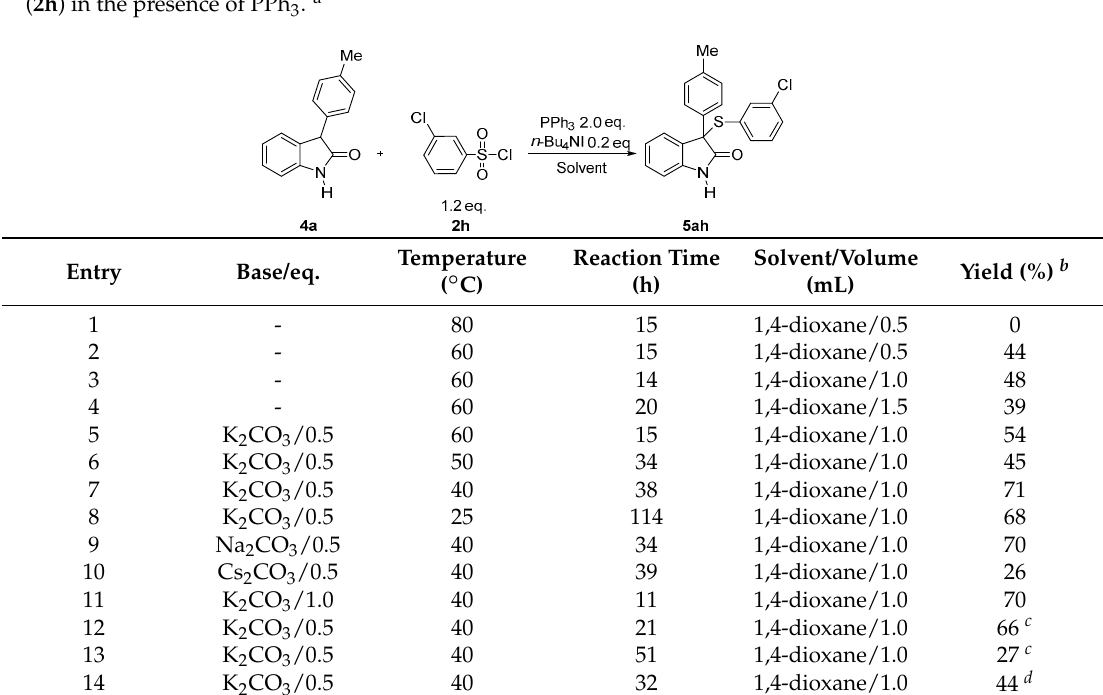
Table 3. Optimisation of 3-( p -tolyl)indolin-2-one ( 4a ) thiolation by 3-chlorobenzenesulfonyl chloride ( 2h ) in the presence of PPh 3 . a